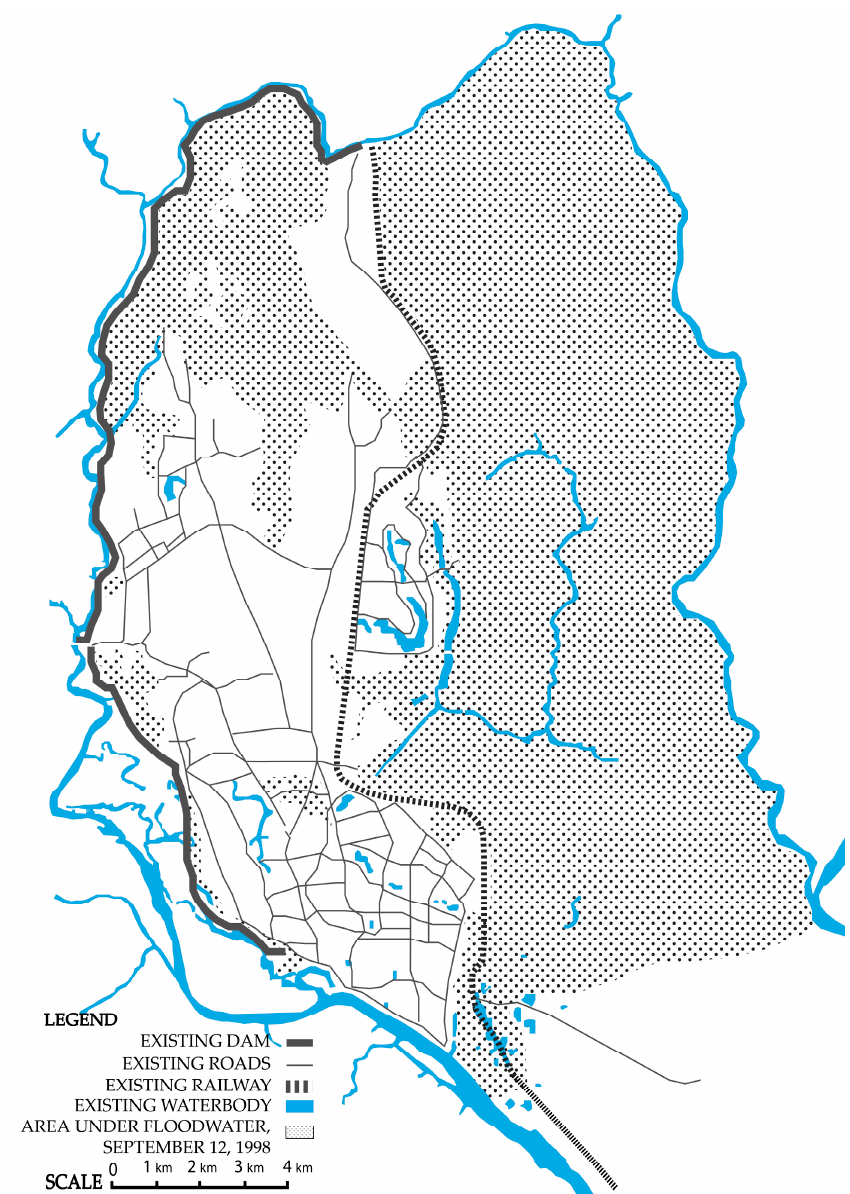
Figure 2. Flood-affected areas during the historic 1998 flood in Dhaka. Figure 2. Flood-a ff ected areas during the historic 1998 flood in